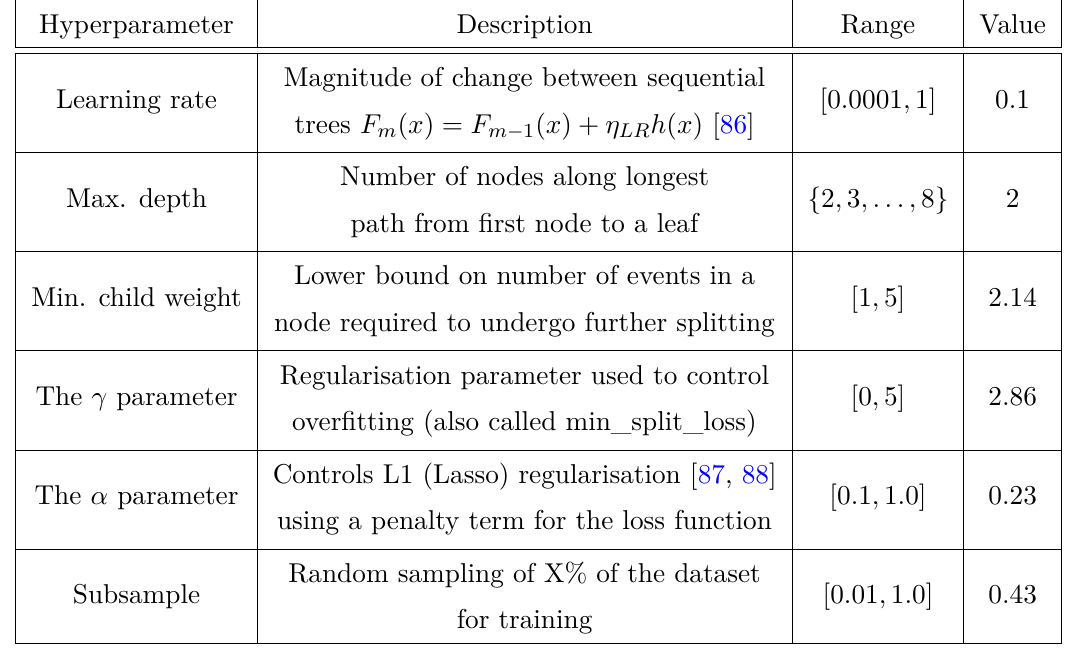
Table 5 . Hyperparameters used by XGBoost . The hyperparameters are specific to the mass benchmark on which the XGBoost toolkit is to be applied. The value indicated as an example corresponds to the (200 , 60) benchmark as an